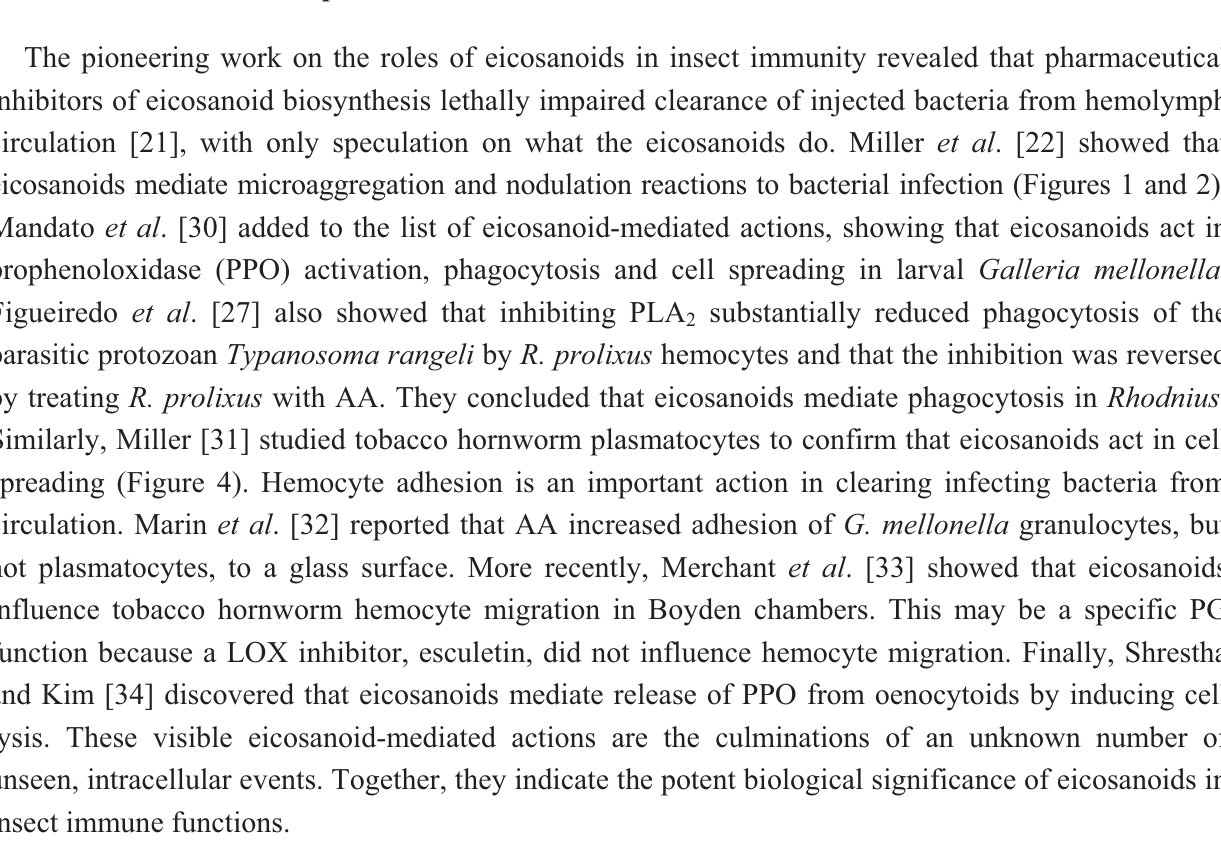
Figure 4. Eicosanoids act in plasmatocytes elongation on glass slides. The line indicates the method of measuring the length (marked L) and the corresponding width (marked W). Photo by